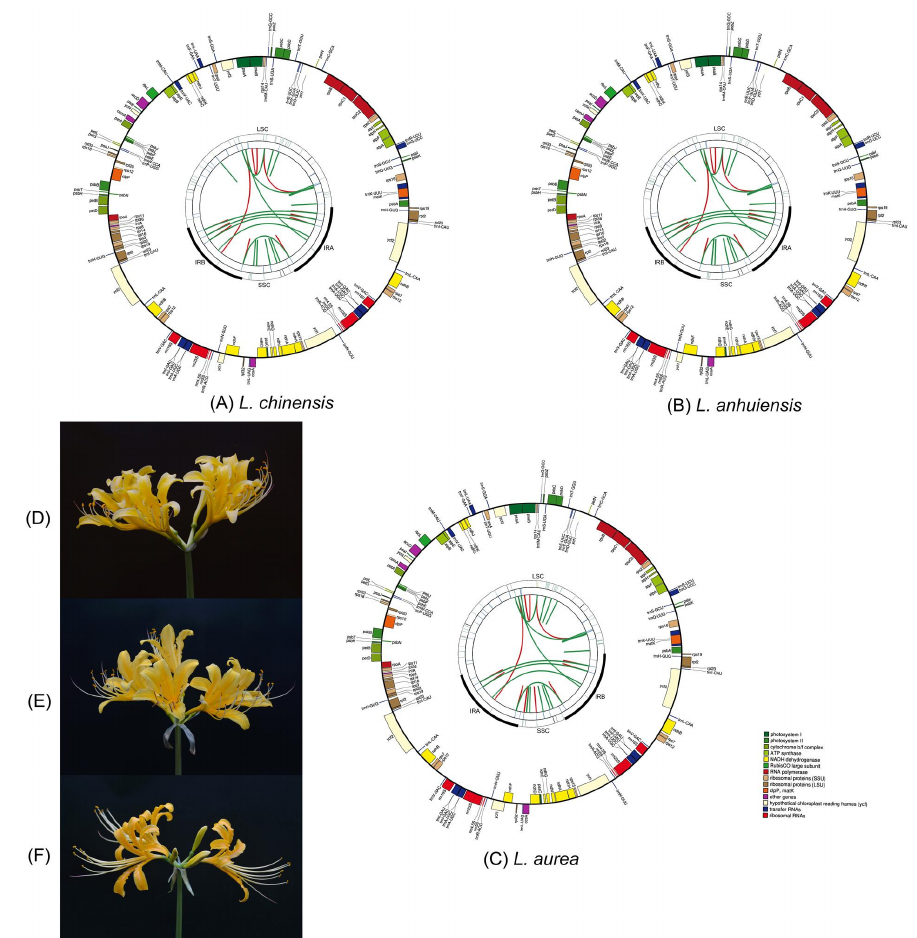
Figure 1. The plastome features and morphological characteristics of L. chinensis , L. anhuiensis , and L. aurea . ( A , D ) are the plastome features and morphological characteristics of L. chinensis. ( B , E ) are L. anhuiensis . ( C , F ) are L. aurea. The schematic map contain four circles from the center going outward, the first circle shows the forward and reverse repeats connected with red and green arcs, respectively. The next circle shows the tandem repeats marked with short bars. The third circle shows the microsatellite sequences. The fourth circle shows the gene structure on the plastome. The genes were colored based on their functional categories. ( A – C ) represented the L. chinensis , L. anhuiensis, and L. aurea ,